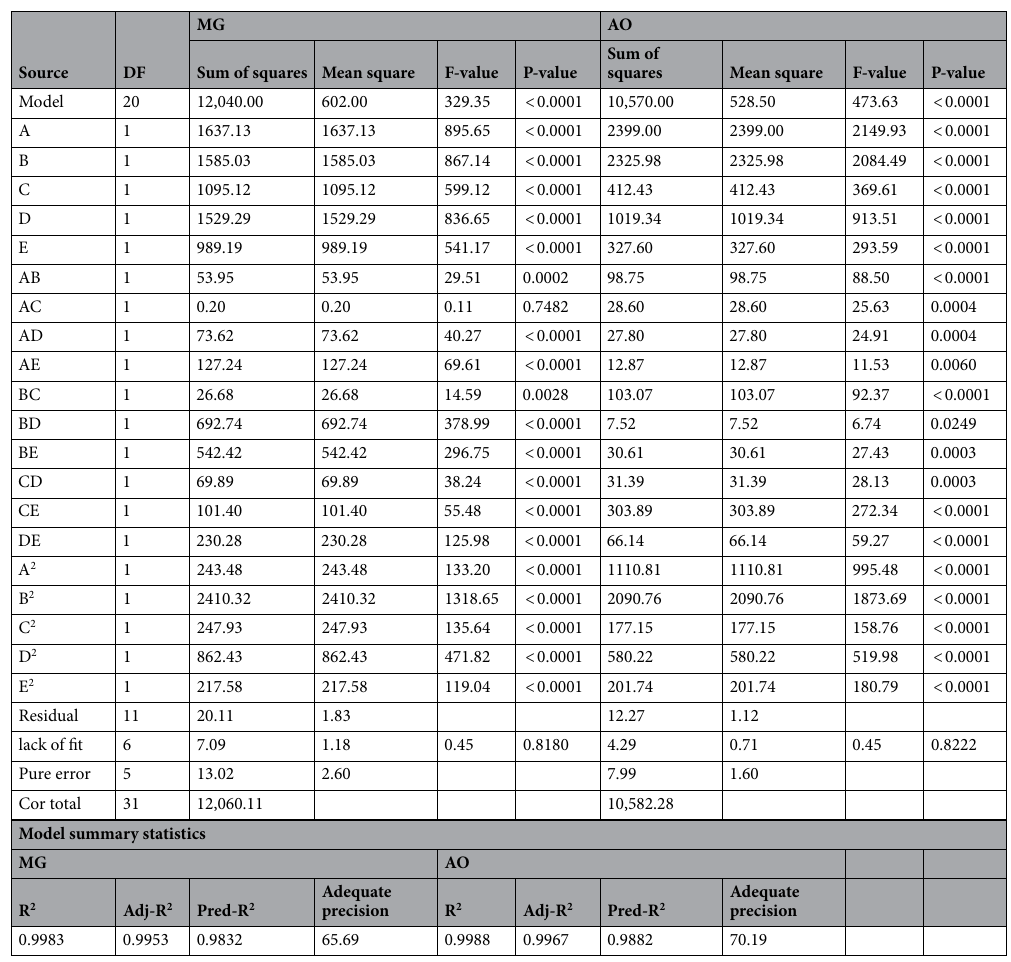
Table 6. Analysis of variance for the quadratic polynomial model for removal of MG and AO. A: adsorbent dosage (mg), B: pH of the solution, C: MG concentration (mg L −1 ), D: AO concentration (mg L −1 ) and E: sonication time